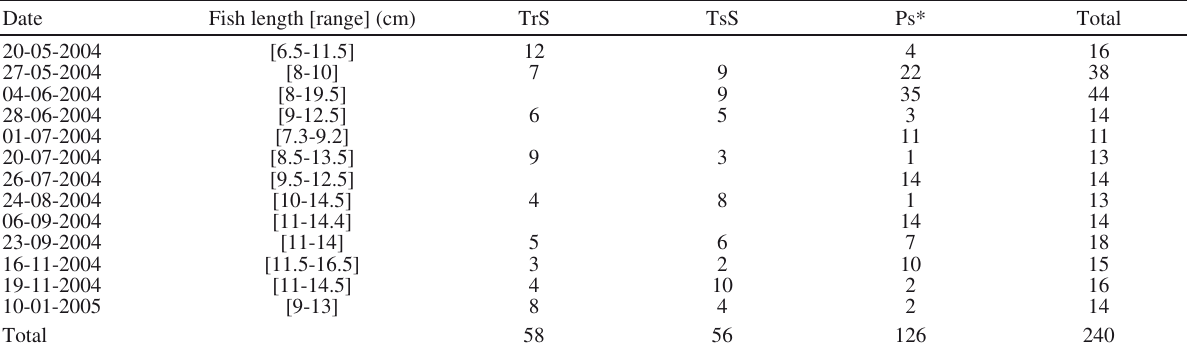
Table 1. – Sampling date, fish length range and number of sardine juveniles per sample. TrS, training sample; TsS, test sample; Ps, pooled sample. Total number includes the number of individuals in the TrS, TsS and Ps. *Total number of the remaining individuals (n=126) for which morphometric characteristics were recorded but age was not observed.